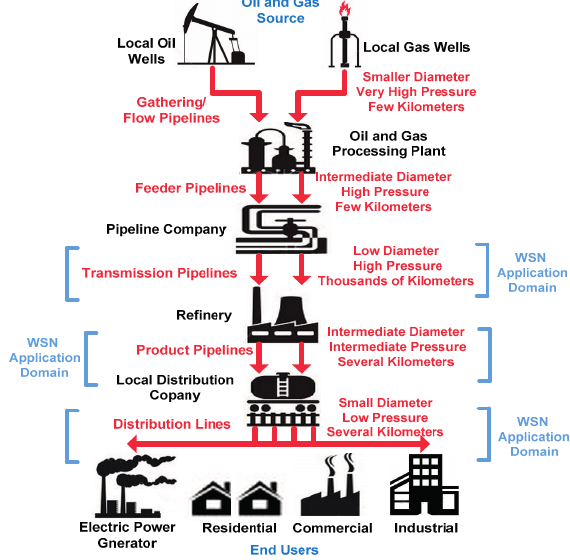
Figure 12. Sample pipeline configuration levels for oil and gas